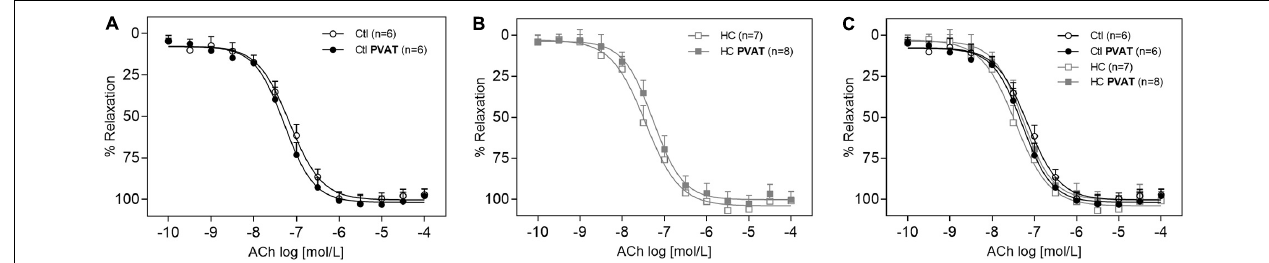
FIGURE 3 | Vasodilator response induced by ACh in the presence or absence of PVAT in aortas of control and HC groups. Cumulative concentration-response curves for ACh in the presence or absence of PVAT in aortas of (A) control, (B) HC, and (C) overlapping curves of control and HC groups. Values represent mean ± SEM. The total number of animals required to carry out the experiments in each group ( n ) is presented in parentheses in the graphs. Statistical significance was determined using two-way ANOVA followed by Holm–Sidak’s post hoc test.